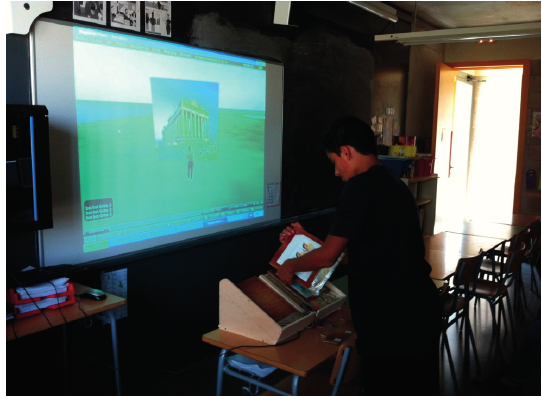
Figure 11. A student using the Virtual Touch